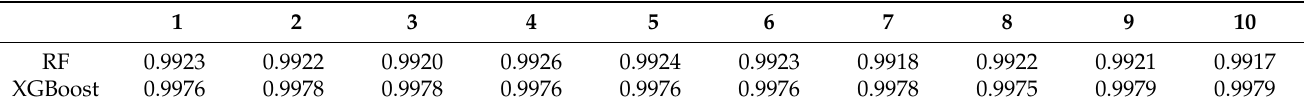
Table 4. R 2 over ten times of evaluation.